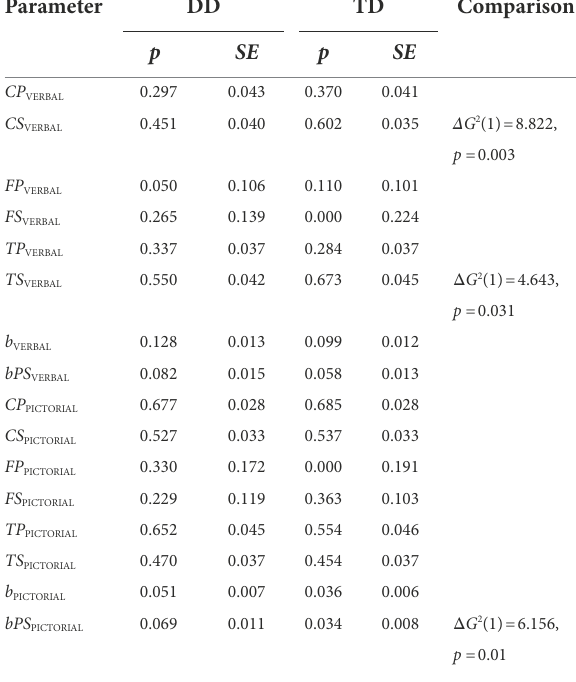
TABLE 5 Parameter estimates and their standard errors for the dual processing multinomial model with the verbal and pictorial memory in the context of the perceptual and semantic similarity and the results of G 2 tests of between-groups